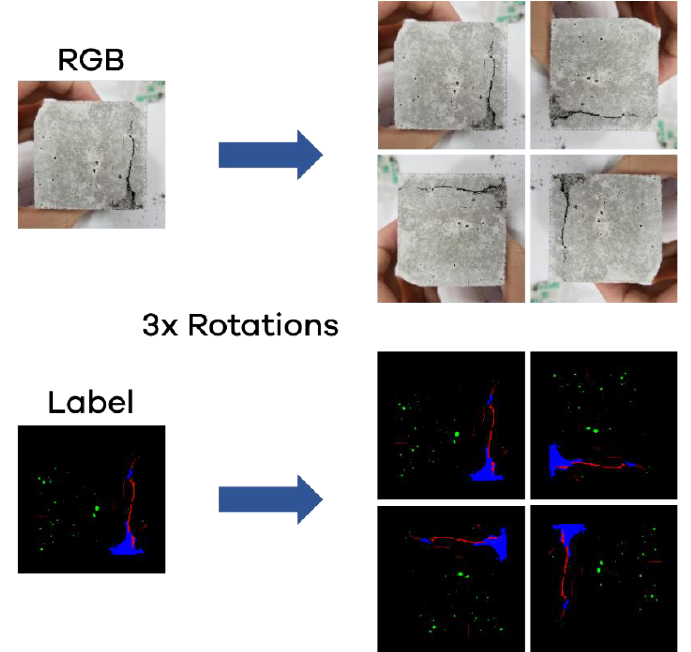
Figure 2. Data augmentation using rotation.